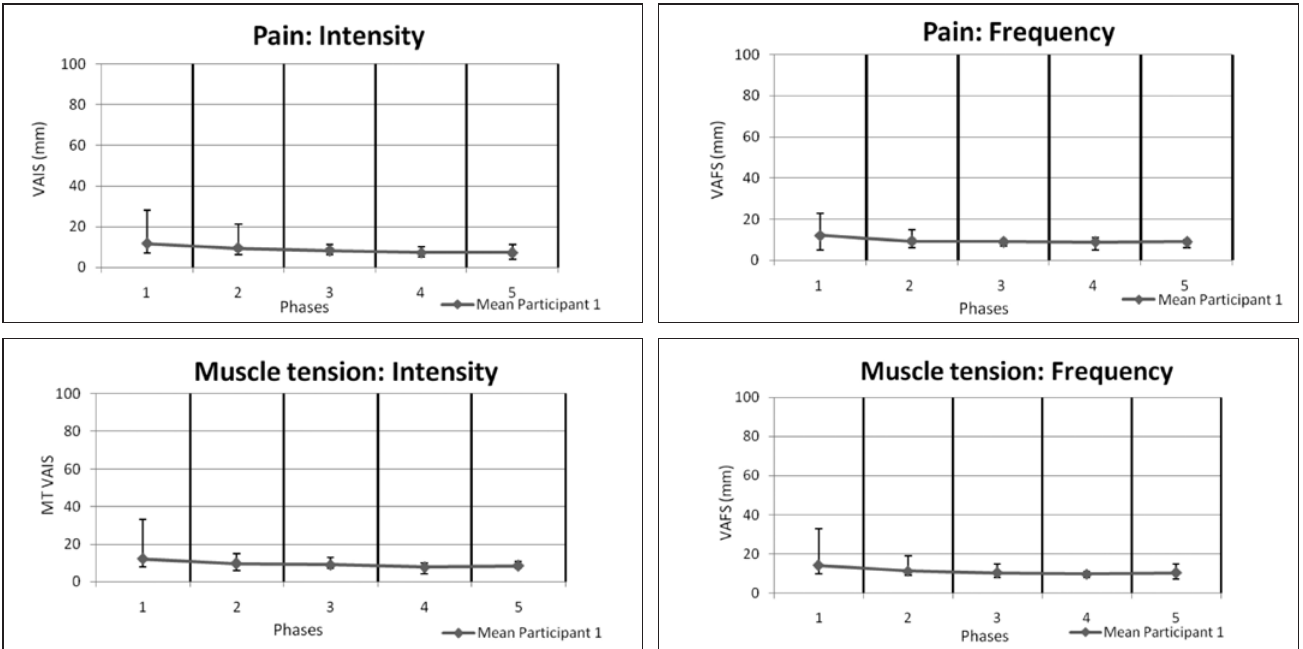
Figure 2: Graphs depicting mean values for VAS outcomes for Participant 1 showing variability of data for each